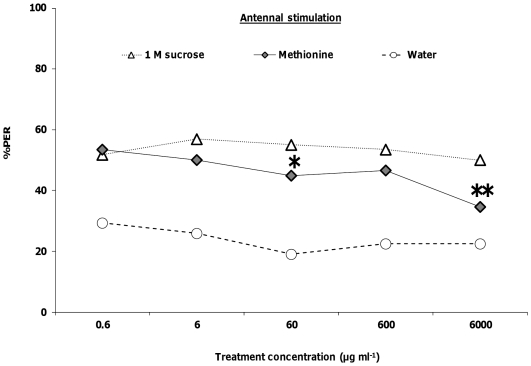
Honey bee behavioral responses to antennal stimulation with methionine.Honey bees were stimulated with 1 M sucrose, water, and methionine in 1 M sucrose (N = 58). Asterisks indicate significance of *P<0.05, **P<0.001, ***P<0.0001 (Logistic regression with multiple comparisons) between 1 M sucrose and treatment lines.